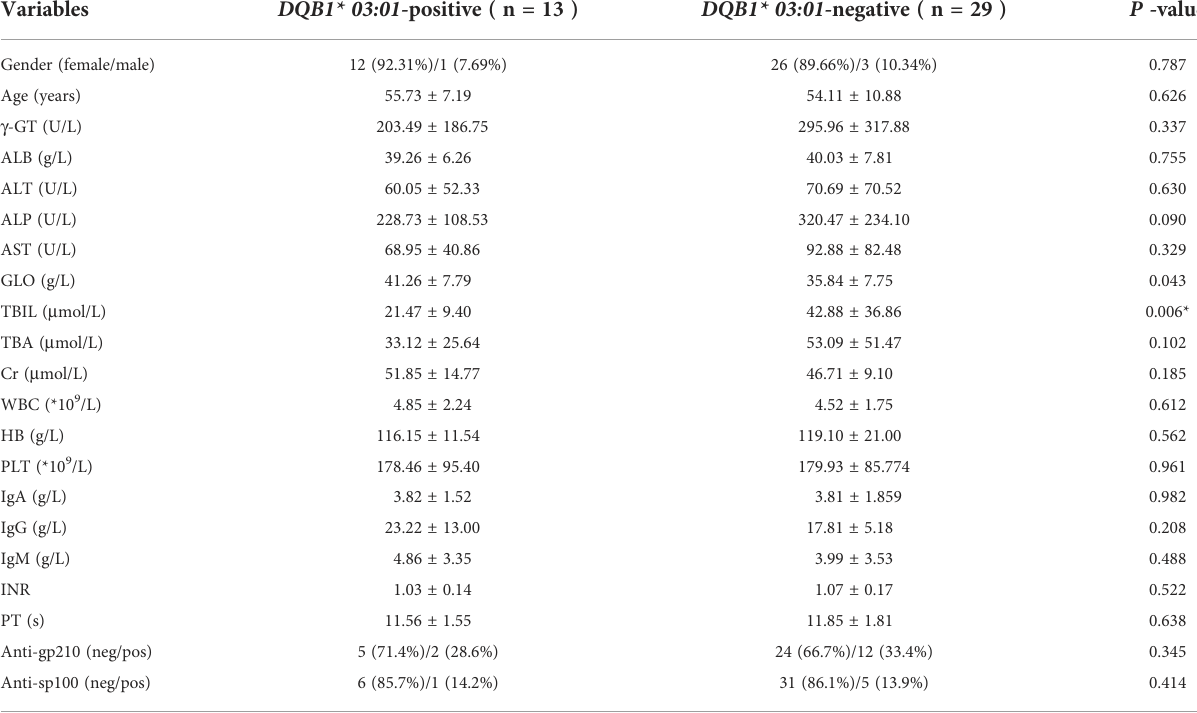
TABLE 2 The baseline characteristics of PBC in the DQB1* 03:01- positive and DQB1* 03:01 -negative groups.